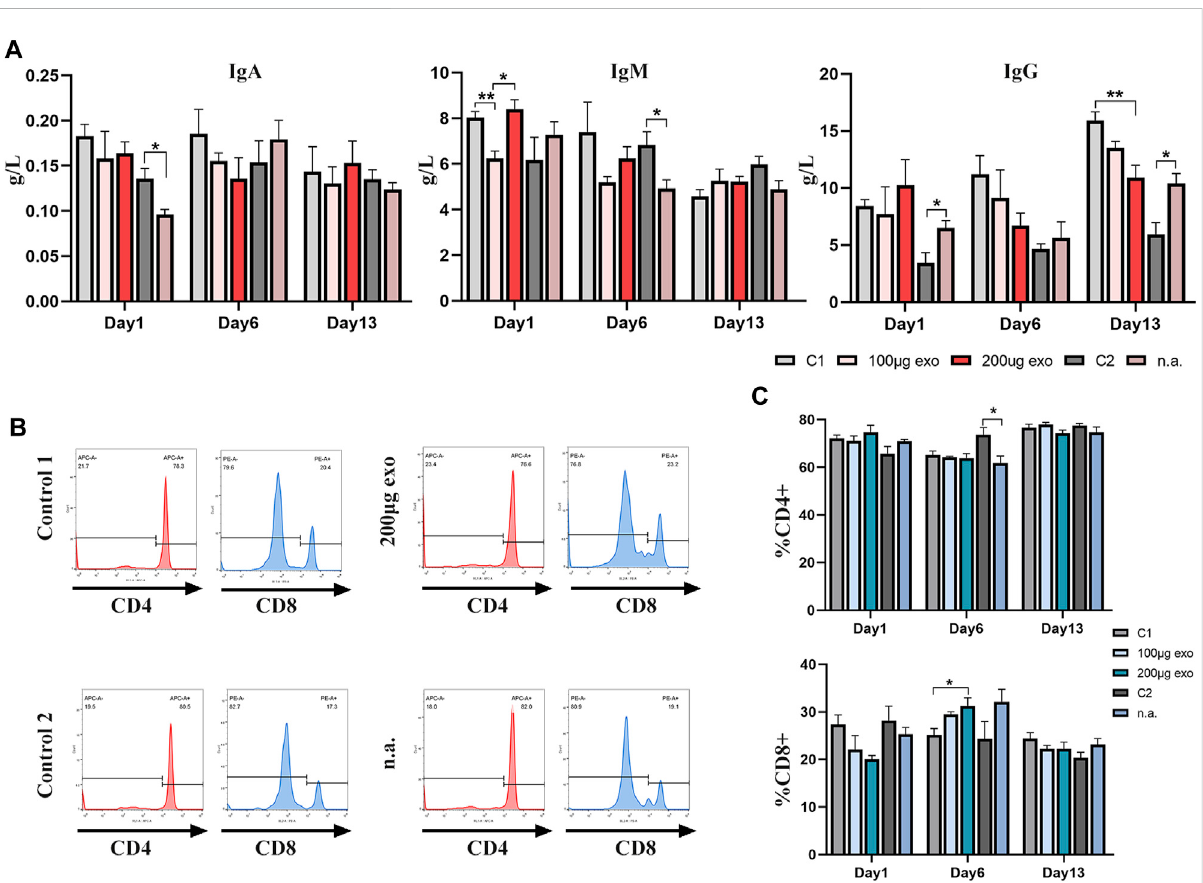
EffectsofhiPSC-exosomesonhumoralandcellularimmunities. (A) ChangesofIgA,IgM,andIgGcontentsinthefourgroupsofratsondays1,6, and13. N =4pergroup(* p < 0.05;** p < 0.01). (B)